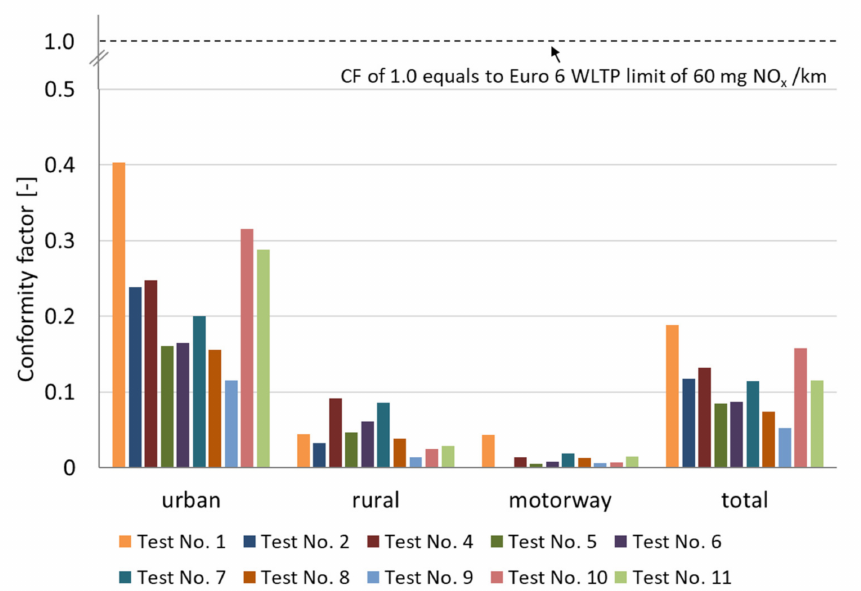
Figure 14. CFs for NO x emissions of the performed real-world driving tests with the studied